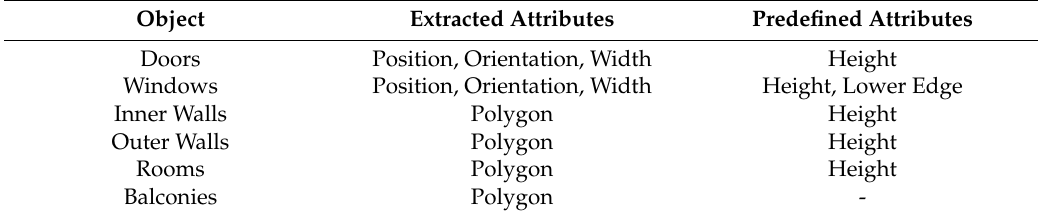
Table 1. Components, which have to be extracted and attributes which have to be manually predefined.